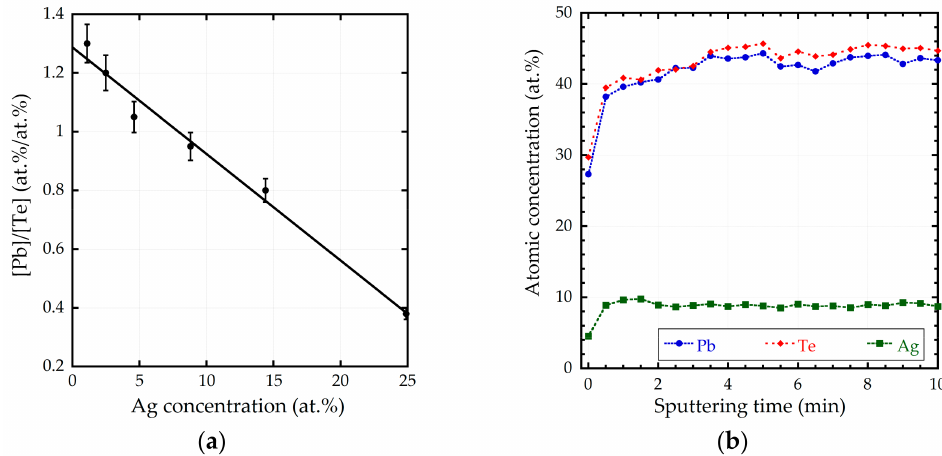
Figure 2. ( a ) [Pb]/[Te] atomic concentration ratio as a function of the Ag concentration; ( b ) XPS depth profile for the sample PbTe05.